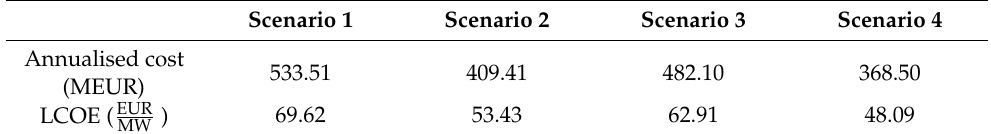
Table 2. Results of the case study: annual cost of owning and operating the MES per